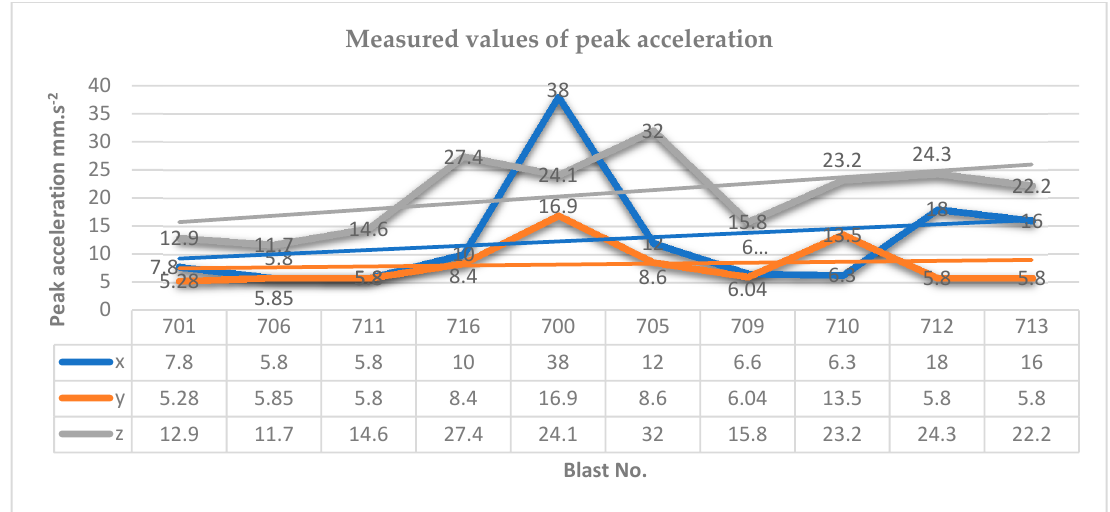
Figure 11. Dependence of measured values of peak acceleration (source: author).